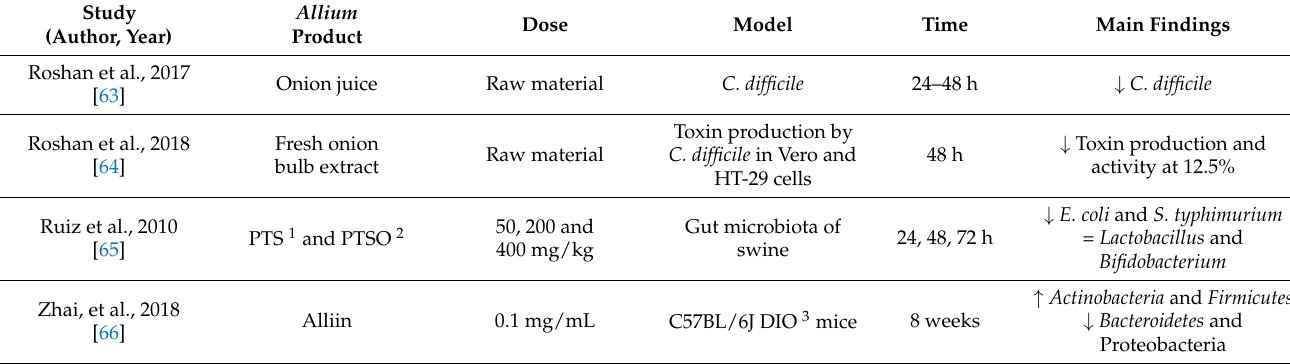
Table 1. Overview of studies reporting the evaluation of OSCs from Allium on gut